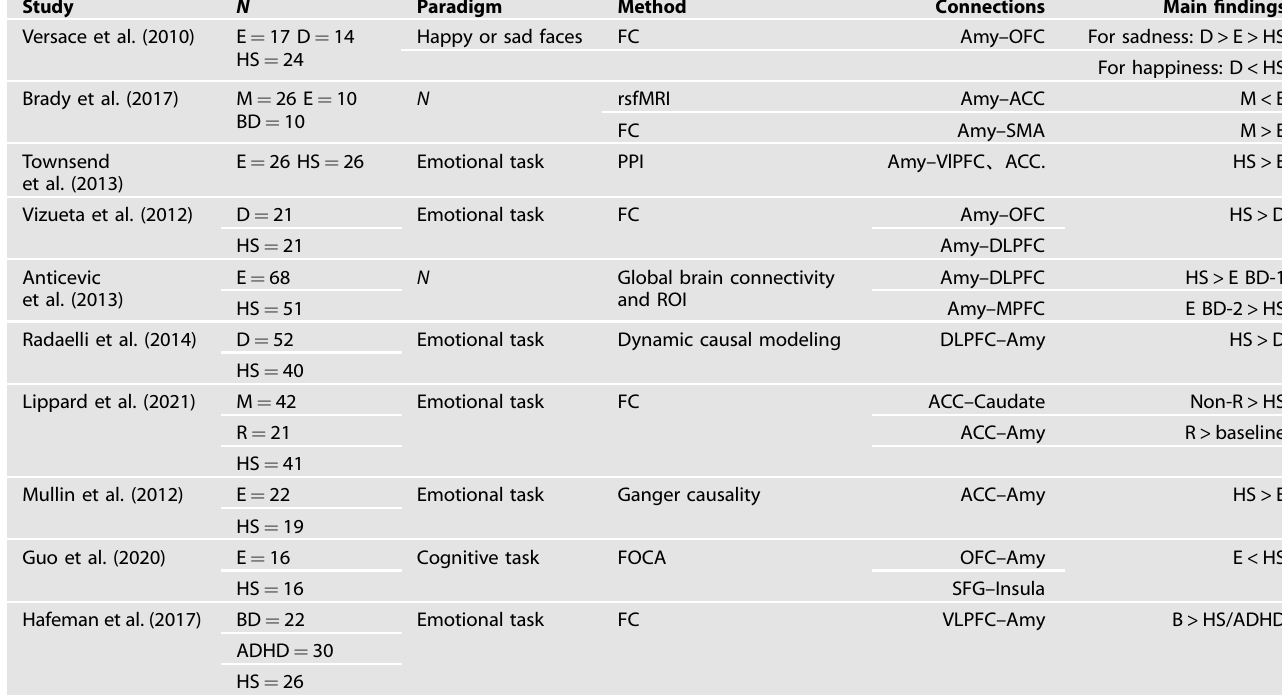
Table 1. The fronto-limbic system results of fMRI emotion studies in